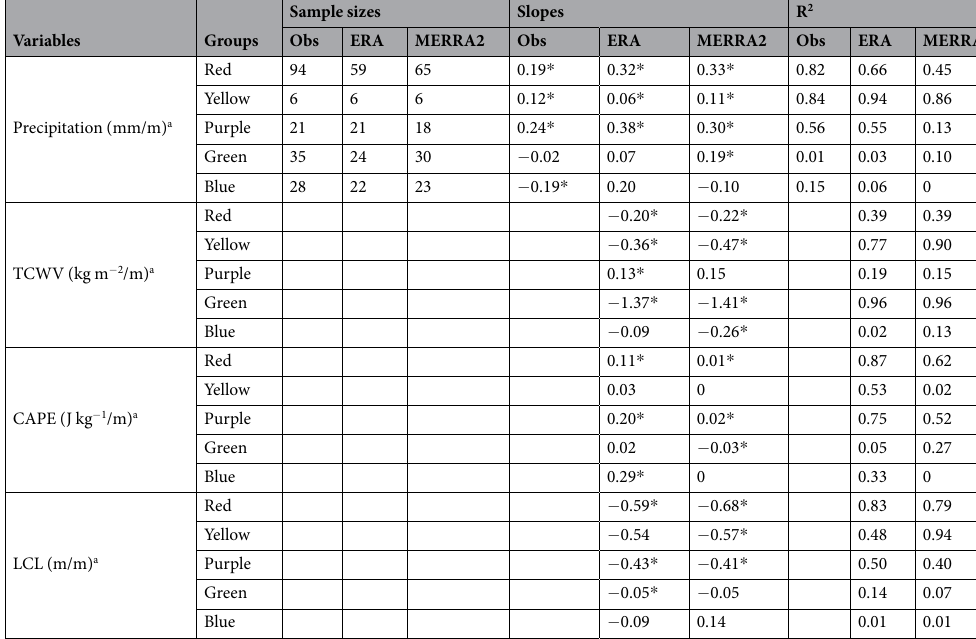
Table 1. Slopes and coefficients of determination (R 2 ) of the observed (Obs), ERA-Int (ERA) and MERRA2 wet season precipitation, TCWV, CAPE and LCL with respect to elevation. The units of the slopes are denoted by a ; * Represents statistically significant values at 90% confidence level based on the two tailed student